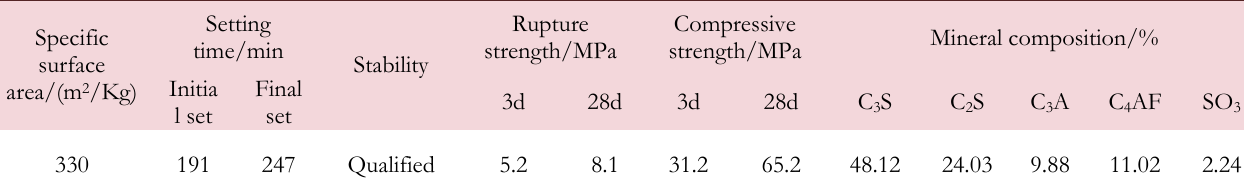
Table 2: The physical properties and mineral composition of the